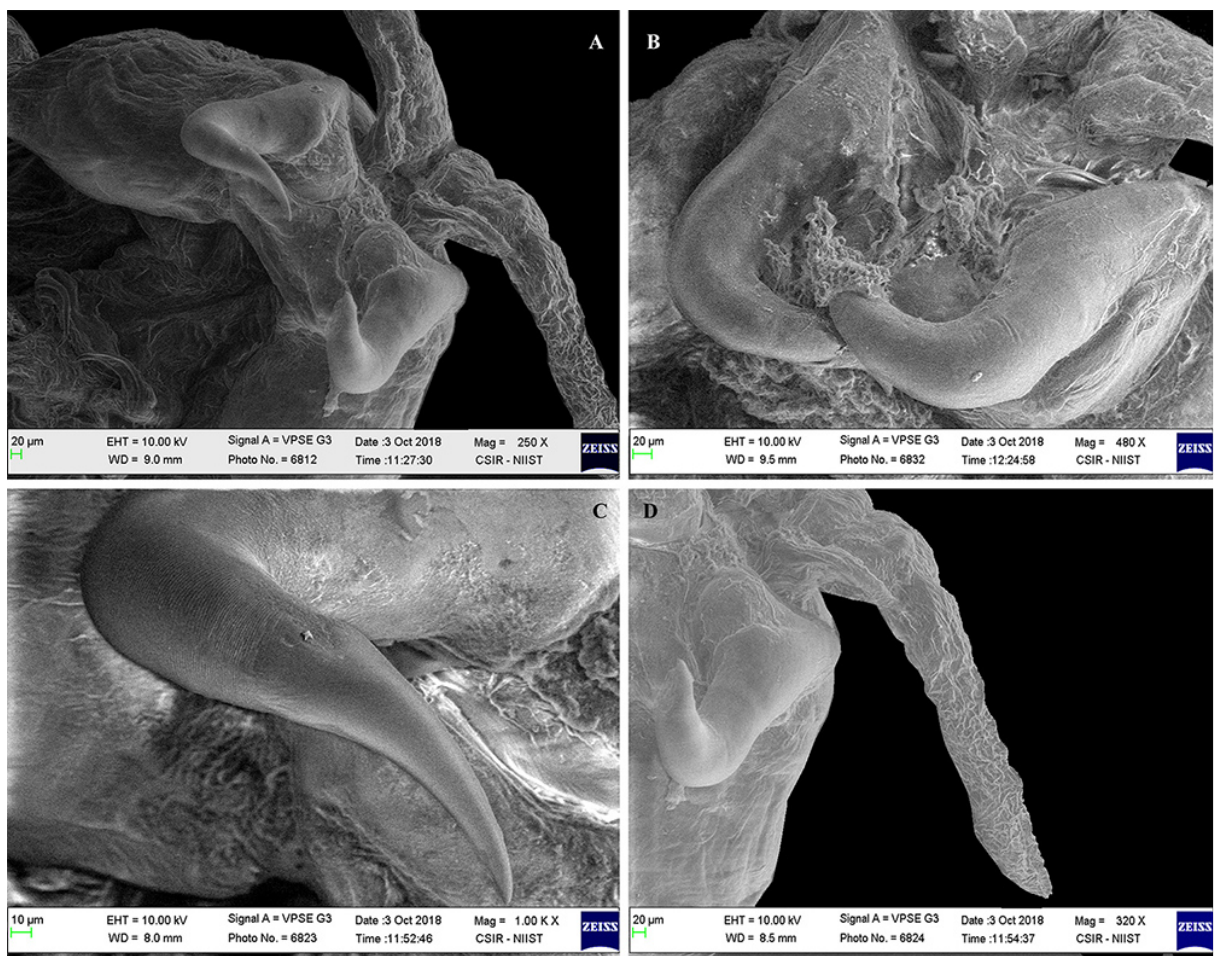
Figure 11. Scanning electron micrographs of Chondracanthus kabatai sp. n., non-type female from Zenopsis conchifer Lowe. A . Head ventral view showing antennule and antenna. B , C . Antenna. D .